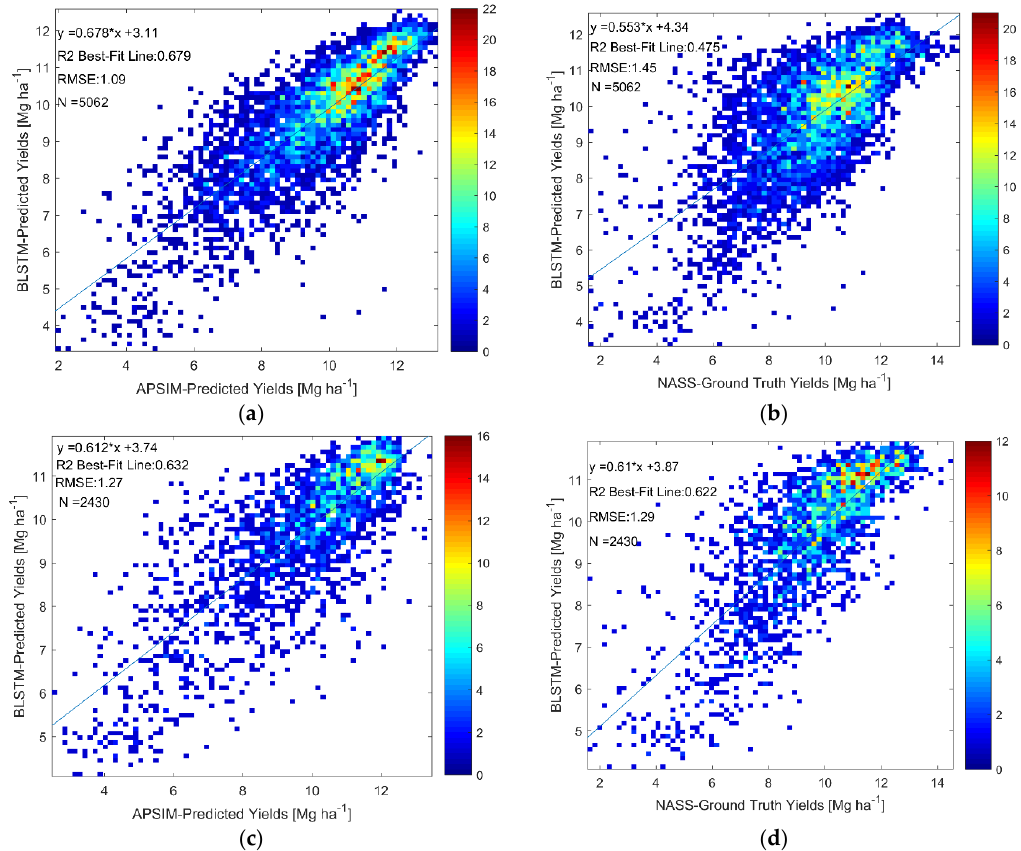
Figure 8. Scatterplots of BLSTM-predicted versus APSIM-predicted ( a , c ) and BLSTM-predicted versus NASS ground-truth ( b , d ) yields ( a , b ) over the entire US Corn Belt using clusterless calibration and ( c , d ) in selected weather clusters using the 20-cluster weather-cluster-based calibration. Colorbars represent number of points at a particular pixel in the scatterplot. Table 5. BLSTM performance in retrieving phenological stage transition